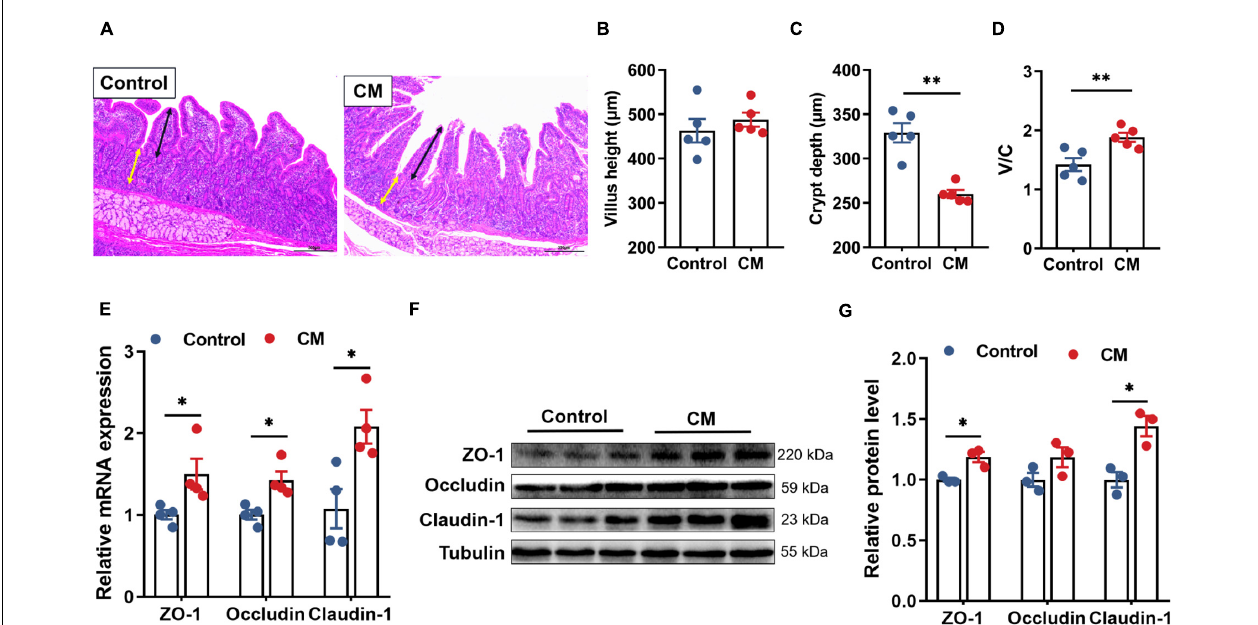
FIGURE 1 | CM improves duodenal morphology and physical barrier function. (A) HE-stained section of duodenum, ↔ (black) represents the height of villi, ↔ (yellow) represents the depth of crypts. (B) The villus height ( n = 5). (C) The crypt depth ( n = 5). (D) The ratio of the villus height and crypt dept ( n = 5). (E) RT-qPCR analysis of tight junction proteins ZO-1, occludin, and cladin-1 ( n = 4). (F,G) Western blot analysis of tight junction proteins ZO-1, occludin, and cladin-1 ( n = 3). Control, pigs fed a basal diet; CM, pigs fed the basal diet supplemented with CM at 300 mg/kg. Data are presented as the mean ± SEM. ∗ P < 0.05, ∗∗ P < 0.01.